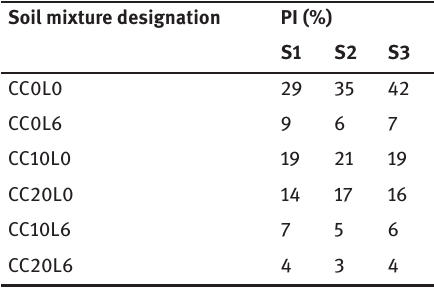
and optimum water content dmax